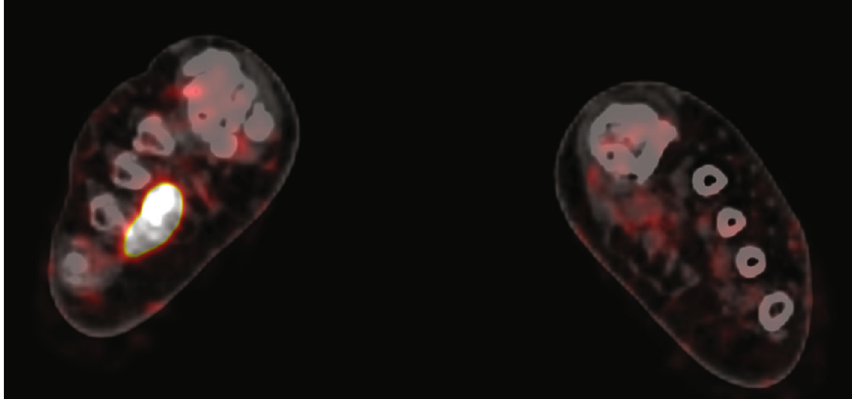
Figure 4: Bilateral feet 68 Ga-DOTATATE-PET/CT images for Case 2. Axial 68 Ga-DOTATATE-PET/CT slice through the bilateral feet demonstrating increased uptake in the right foot plantar soft tissue corresponding to the FGF-23 secreting